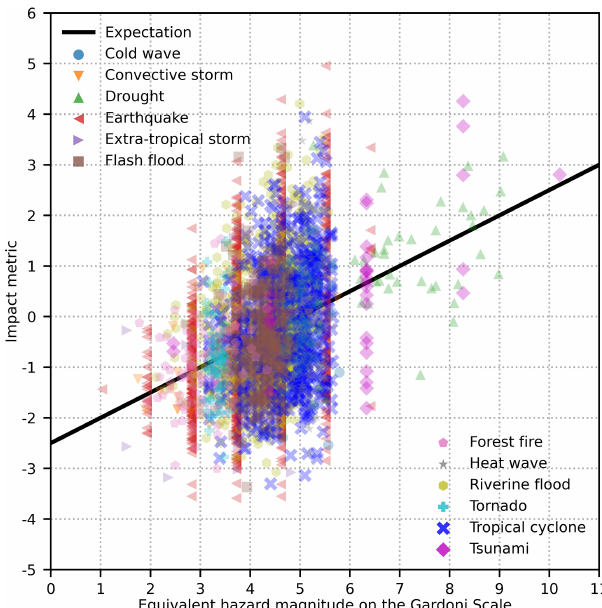
Figure 4. Impact metric versus equivalent hazard magnitude on the Gardoni Scale. The expectation line shows values of the expected impact metric with respect to equivalent hazard